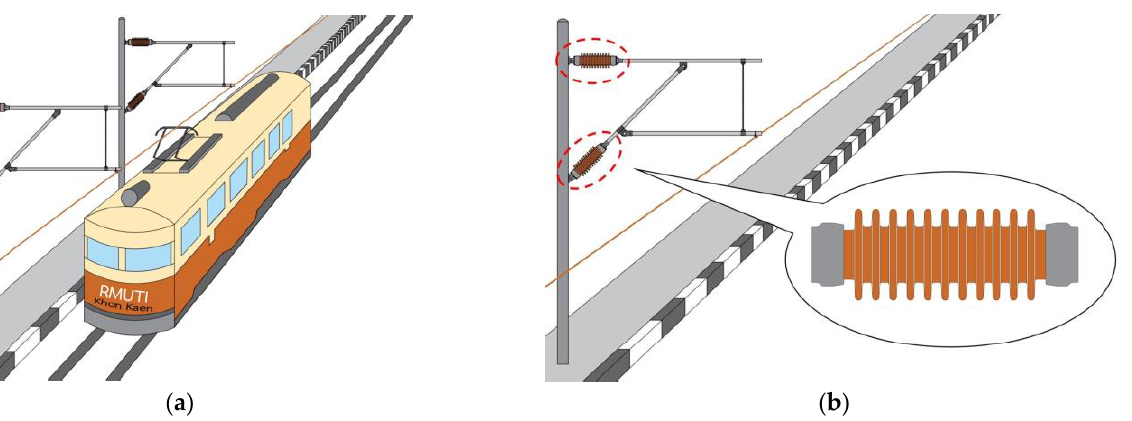
Figure 1. Railway electrification system: ( a ) Overview of railway electrification system; ( b ) Design of overhead line insulation equipment as porcelain